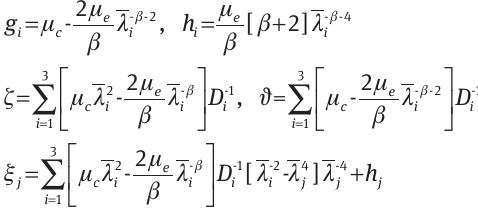
, μ , and β (0 < β ≤ 1) are the material parameters. where μ c e In Eq. (79), Ψ and Ψ represent the energy contribu- iso , c iso , e tions from chain cross-linking and chain entanglements, respectively, and the cross-linking part is somehow moti- vated from the Neo-Hookean energy, i.e., Gaussian statis- tics of chain molecules. The coefficients required for the stress tensor and tangent operator are derived from the energy function